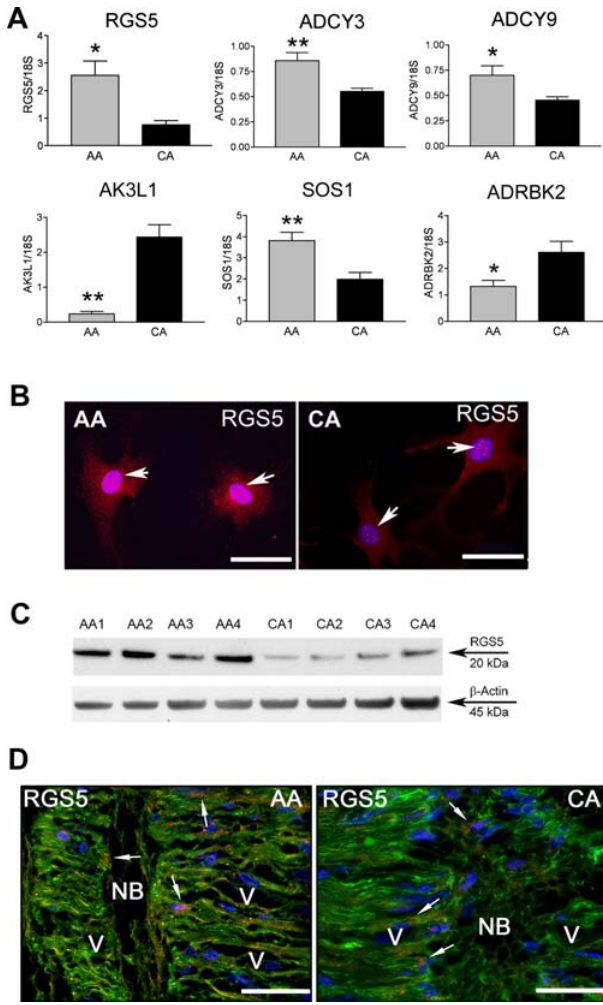
Figure 2. Signal transduction pathways in AA astrocytes compared to CA astrocytes. A. Confirmation of six differentially expressed signaling genes by qRT-PCR in human normal ONH astrocytes: RGS5, ADCY3, ADCY9, AK3L1, SOS1 and ADRBK2. Genes were normalized to 18S. Graphical representation of the relative mRNA levels in normal AA and CA astrocytes (n=8, respectively, two-tailed t test was used. **indicates p , 0.01 and * indicates p , 0.05). B. Cellular localization of the Regulator of G protein signaling 5 (RGS5) in primary cultures of ONH astrocytes. Immunofluorecent staining of RGS5 (red) demonstrated higher levels of RGS5 protein in AA astrocytes, compared to CA astrocytes. Nuclei stained with DAPI (blue). Note that RGS5 localizes to the cytoplasm and in the nucleus of astrocytes (arrows). Magnification bar: 25 m m. C. Representative Western blots of astrocyte cell lysates with human RGS5 antibody and b -actin used as a loading control. Note that AA1-4 normal donors express more RGS5 than CA1-4 donors. D. Representative double immunofluorescent staining of RGS5 (red) astrocyte marker GFAP (green) in sections of human ONH from an AA donor (71 year-old male) and a CA donor (75 year-old male). Nuclei stained with DAPI (blue). Note strong granular staining of RGS5 in astrocytes (arrows) in the cribriform plates in the lamina cribrosa. Fewer astrocytes stain for RGS5 in the lamina cribrosa of a CA donor. V: blood vessel, NB: nerve bundle, Magnification bar 55 m m.